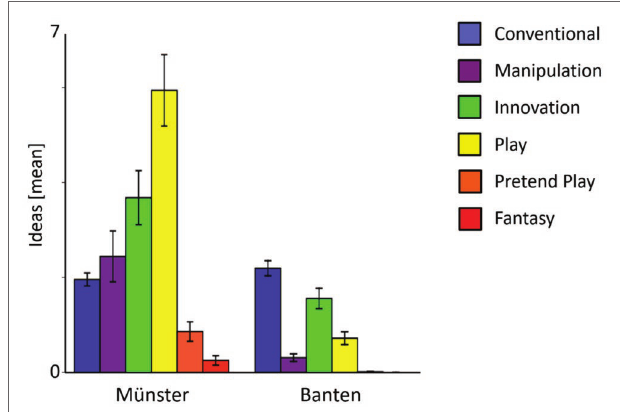
FIGURE 3 | The mean number of object uses uttered within each of the six categories for the alternate uses task (Conventional, Manipulation, Innovation, Play, Pretend Play, and Fantasy). The cross-cultural comparison was not significant for Conventional responses ( p = 0.456), but highly significant for all other categories, namely Manipulation ( p < 0.001), Innovation ( p = 0.001), Play ( p < 0.001), Pretend Play ( p < 0.001), and Fantasy ( p =